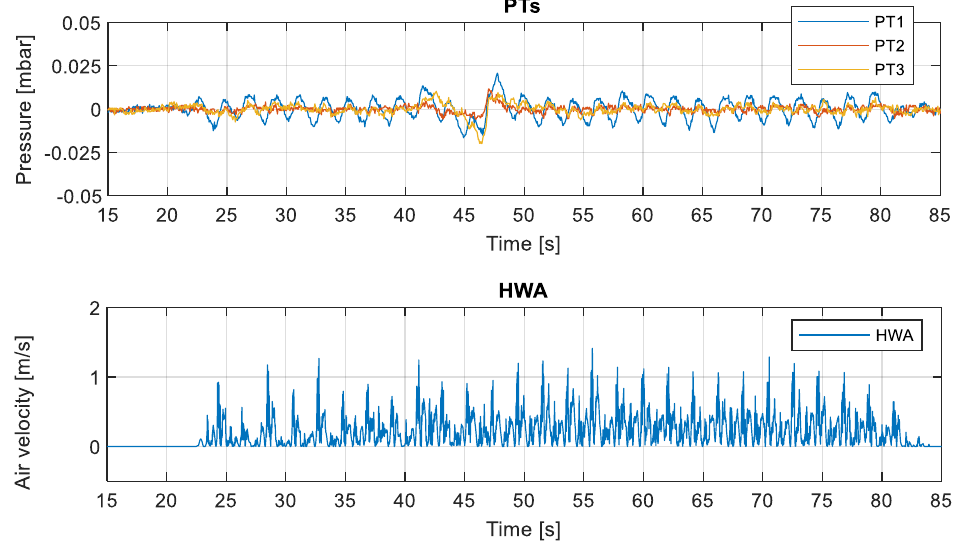
Figure 13. Overview of simultaneous measurements: ( a ) WG3 (located at the model location), ( b ) RWG1, ( c ) LC1, ( d ) PT1, and ( e ) hot-wire anemometer (HWA) for H14 (d = 0.625 m, H = 0.1 m, and T = 2.1 s).